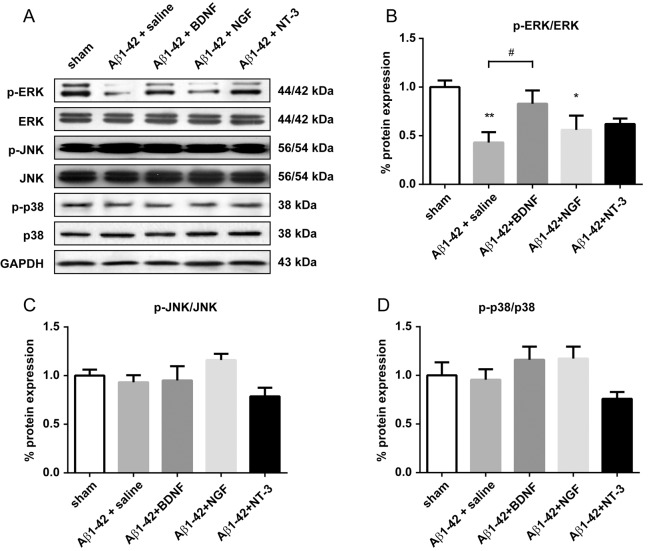
Effect of intra-hippocampal injections of BDNF (1.0 μg), NGF (0.25 μg), and NT-3 (0.25 μg) on MAPK expression in the hippocampus in a rat model of Alzheimer's disease.(A) representative western blots of each group. GAPDH was used as the internal loading control. (B) relative expression of phosphorylated ERK. (C) and (D) relative expression of phosphorylated JNK and p38. * P < 0.05, ** P < 0.01, and *** P < 0.0001 compared with sham controls. # P <0.05 as compared with Aβ1–42 + saline group.